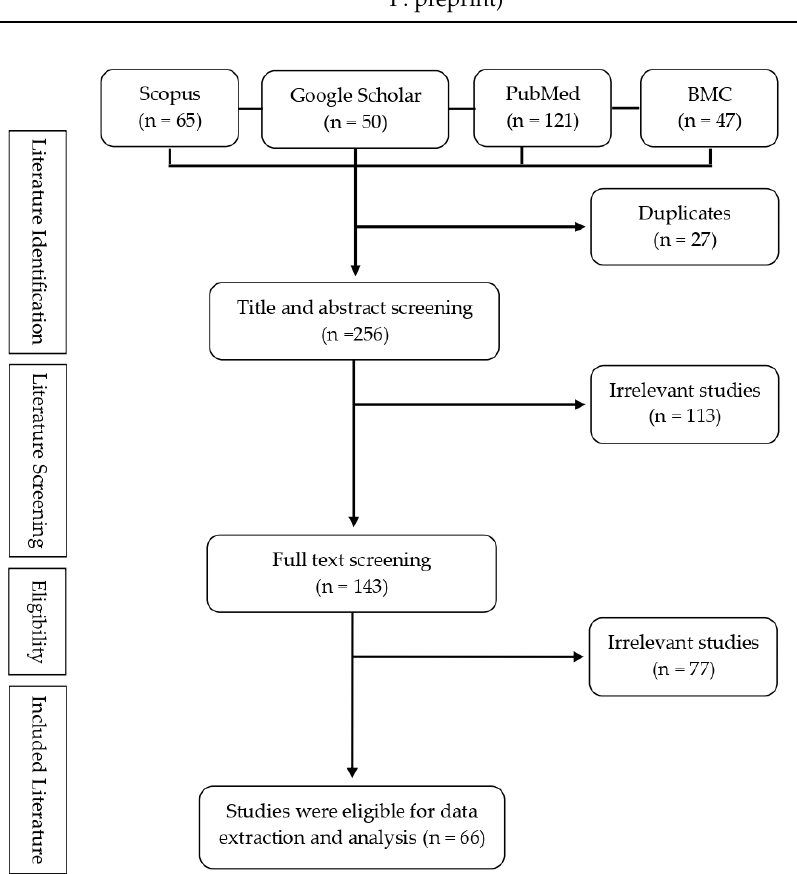
SARS-CoV-2 is a subfamily of Coronaviridae (CoV), part of the Coronaviridae RNA virus family. The two types of CoV viruses that have caused serious illness are SARS-